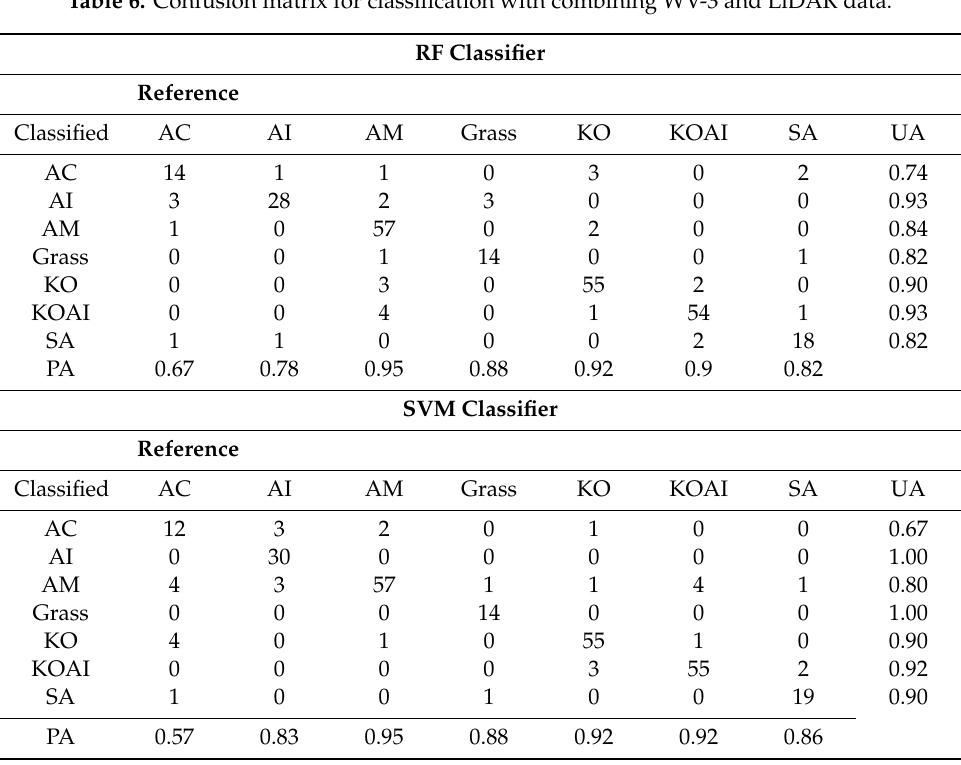
Table 6. Confusion matrix for classification with combining WV-3 and LiDAR